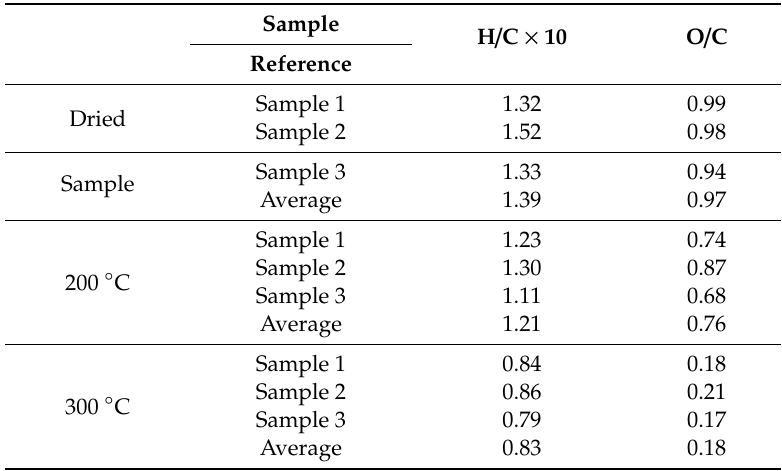
Table 8. H / C and O / C